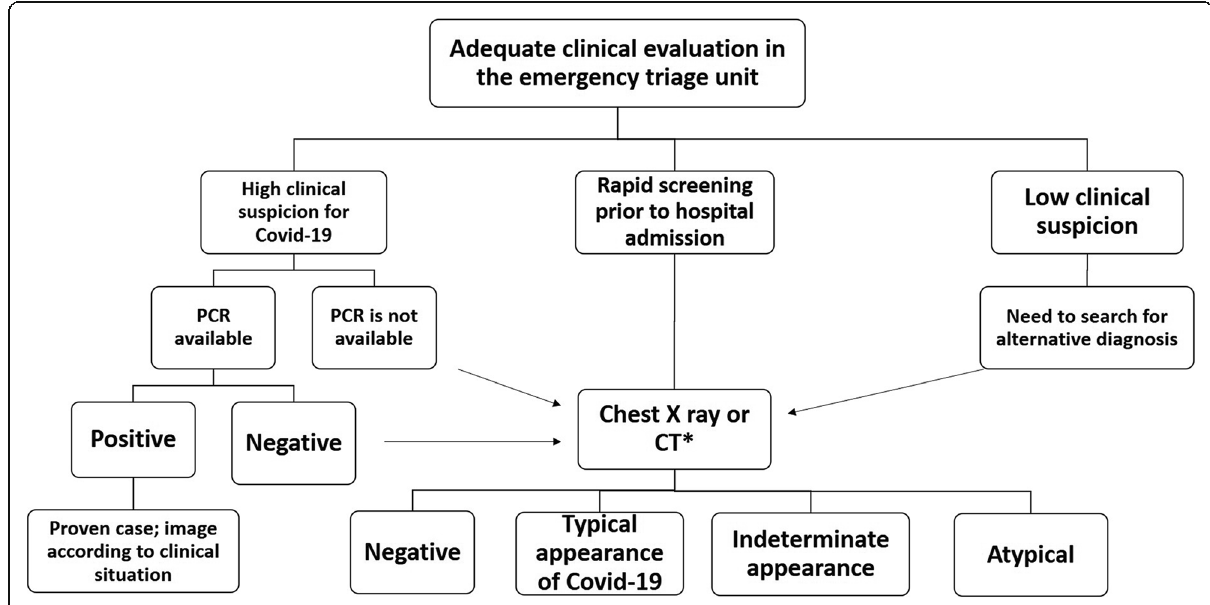
Fig. 4 Recommended diagnostic algorithm for suspected COVID-19 cases presented in our emergency triage unit. Reporting of Chest CT for COVID-19 (as negative for pneumonia, typical, indeterminate, or atypical for COVID-19) was adopted from Simpson et al, 2020